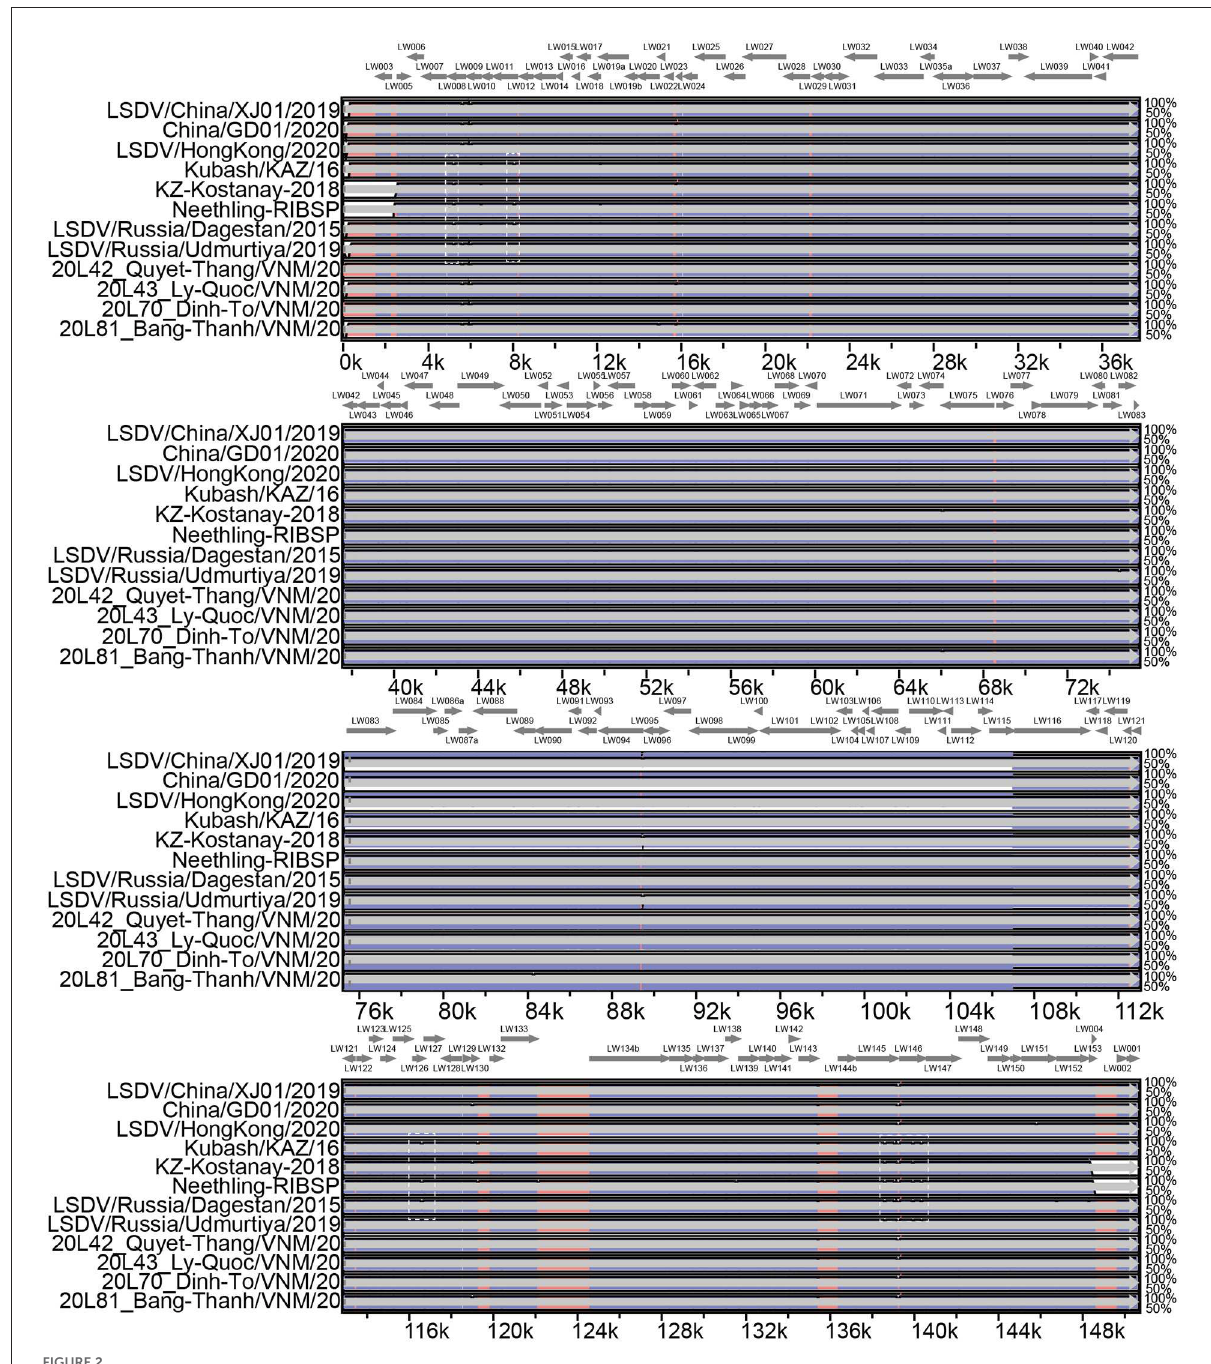
FIGURE2 Multiple genomic sequence alignment of the LSDV strains in and around China. Graph showing sequence similarities between LSDV/China/XJ01/2019 and the strains 20L42_Quyet-Thang/VNM/20, 20L43_Ly-Quoc/VNM/20, 20L70_Dinh-To/VNM/20, 20L81_Bang-Thanh/VNM/20, China/GD01/2020, Kubash/KAZ/16, LSDV/China/XJ01/2019, LSDV/HongKong/2020, LSDV/Russia/Dagestan/2015, LSDV/Russia/Saratov/2017 and LSDV/ Russia/Udmurtiya/2019, which are plotted in a sliding 100-bp window. The seven differentiated regions between the genomes of the Chinese strains and reference strain LSDV/Russia/Saratov/2017 are indicated by white dotted